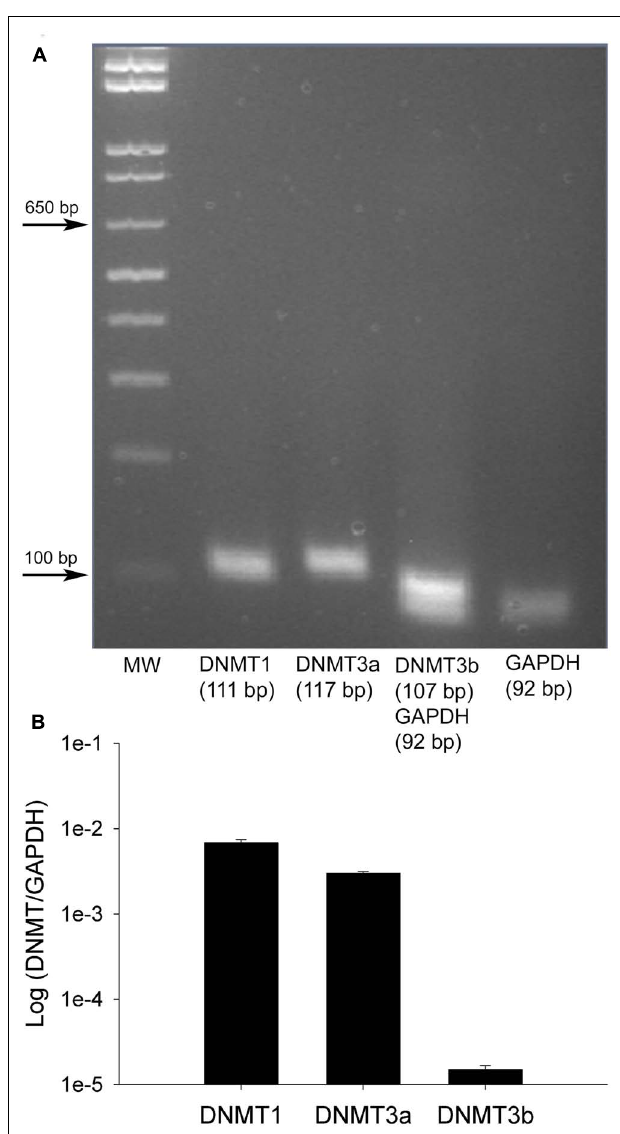
FIGURE 2 | Relative abundance of DNMT transcripts in adult rat DRGs. (A) PCR products run on a 1.8% agarose gel demonstrate a single amplification product for each gene of interest. DNMT3b and GAPDH were run together as this assay involved multiplexing DNMT3b and GAPDH in the same PCR well, thus the two bands in one lane. (B) Quantitative RT-PCR was first used to determine the relative abundance of DNMTs from five naive rats at 1 month of age. All DNMT gene expression is normalized to GAPDH. Note the higher expression levels of DNMT1 and DNMT3a while DNMT3b is lower, consistent with immunocytochemistry data ( Figure 1 ). Note the plot is on a logarithmic scale.